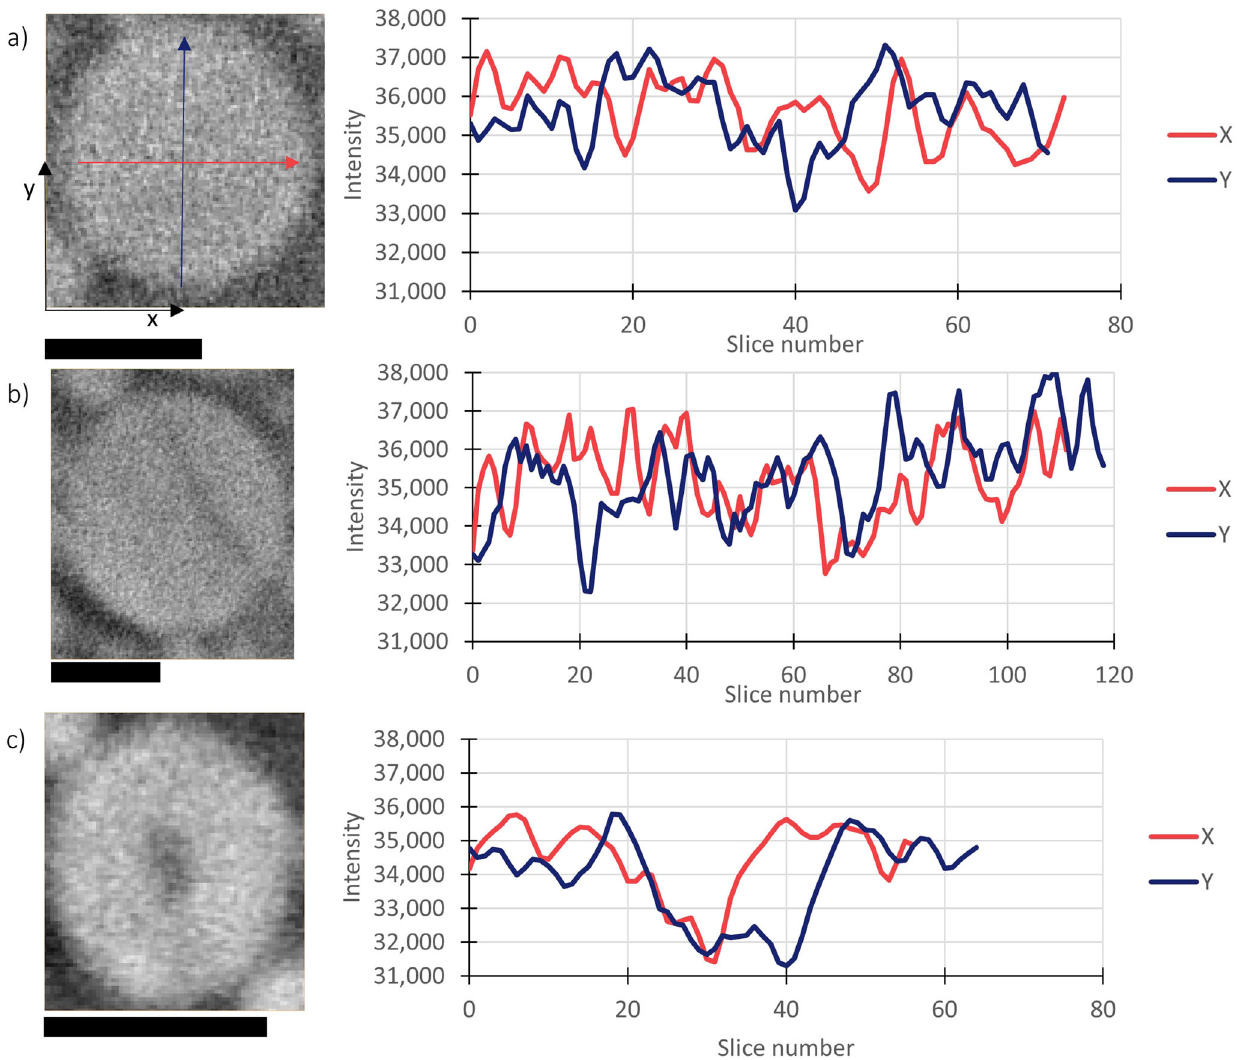
Fig. 1 1D line scans through particles and their respective intensities. 1D line scans through individual particles for an intact particle ( a ), cracked particle ( b ), and particle with an internal void ( c ), and their respective greyscale variations through the radius of the particle. The scale bar is 10 µm for each particle.